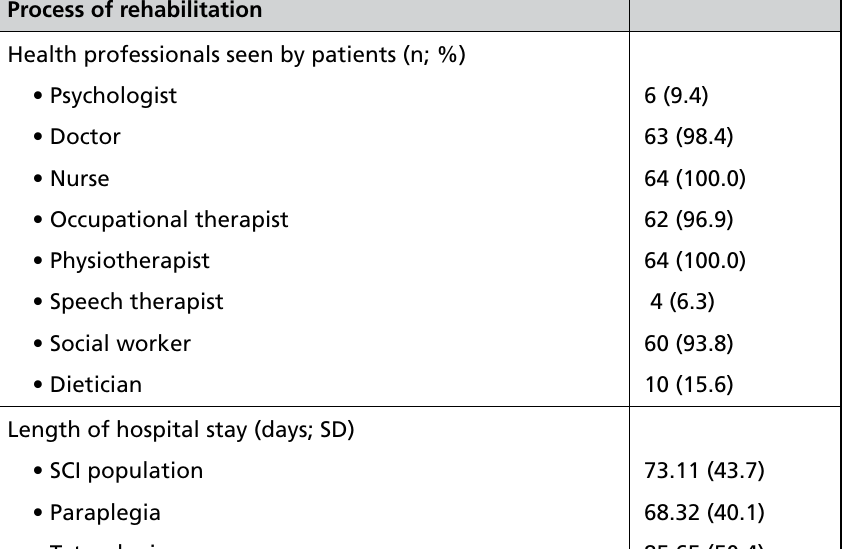
table 2: the process of rehabilitation of pateints with spinal cord injury Process of rehabilitation Health professionals seen by patients (n; %)